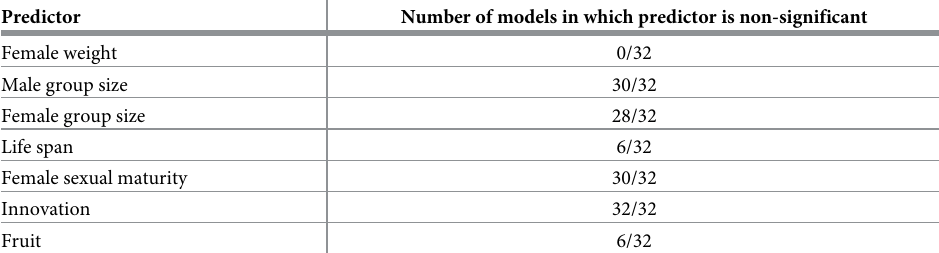
Table 3. Number of models in which each predictor was estimated non-significant ( p > 0.05) with total brain size as the dependent variable. N = 40.